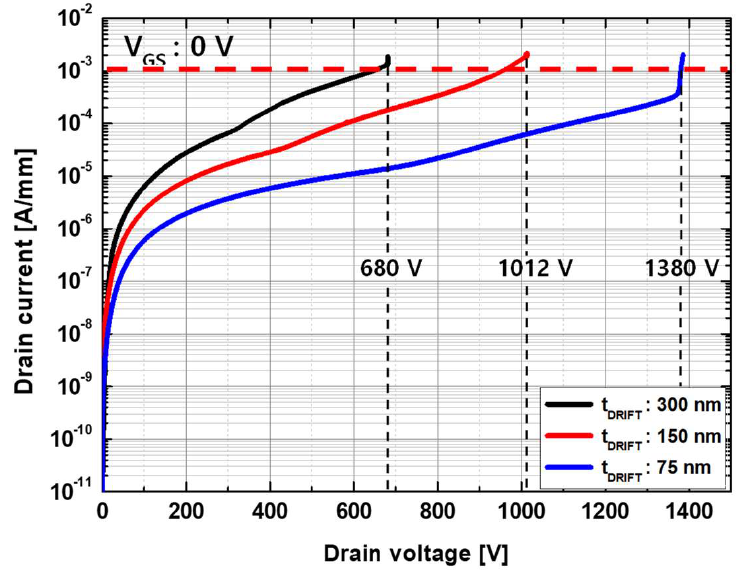
Figure 8. Breakdown voltage characteristics simulated at V GS = 0 V as a function of the drift channel layer thickness. The drift channel layer has a doping concentration of 3 × 10 17 cm −3 .